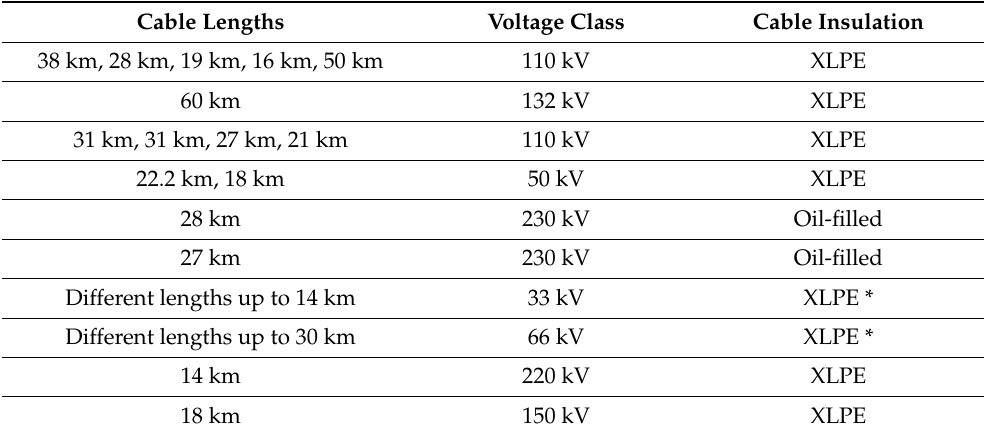
Table 8. The overview of after-laying testing using damped ac test methods of 11 km up to 60 km long HVAC power